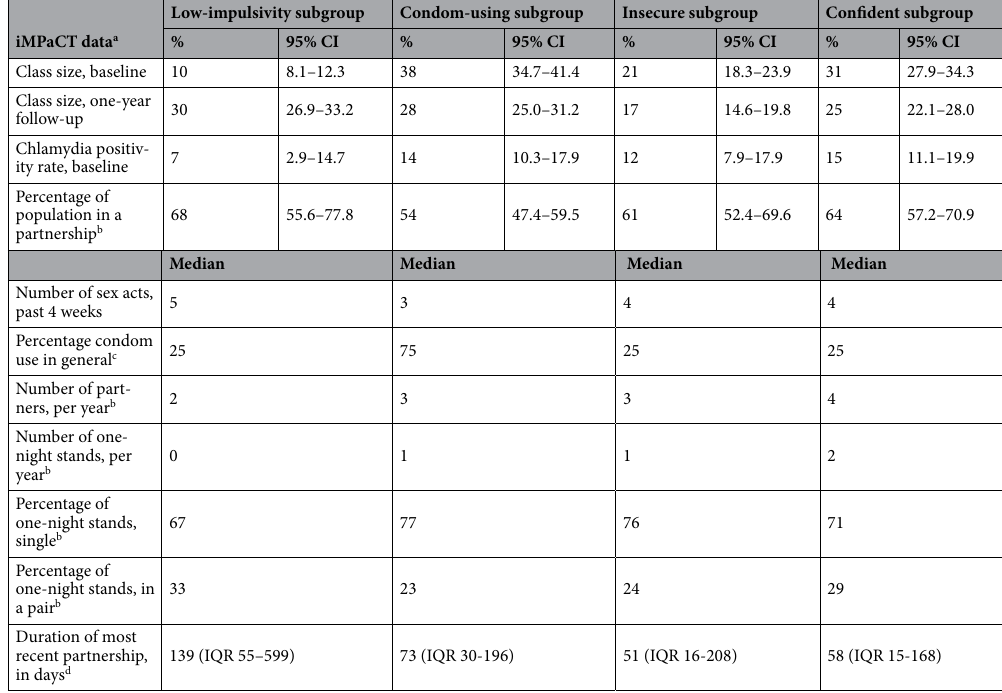
Table 1. Subgroup characteristics among heterosexual males and females aged 18–24 years in the iMPaCT study (n = 810) to inform the mathematical model. a Calculated using behavioural data from the iMPaCT study (see electronic supplementary material, S1.4). b Subset of the study population (n = 627), excluding participants who reported overlap of two most recent partnerships (when duration partnership ≥ 1 day, i.e., not a one-night stand). c Condom use in general ‘How often do you use condoms in general?’ on a scale from 0% (never) to 100% (always). d Subset of the study population (n = 388), excluding participants who reported overlap of